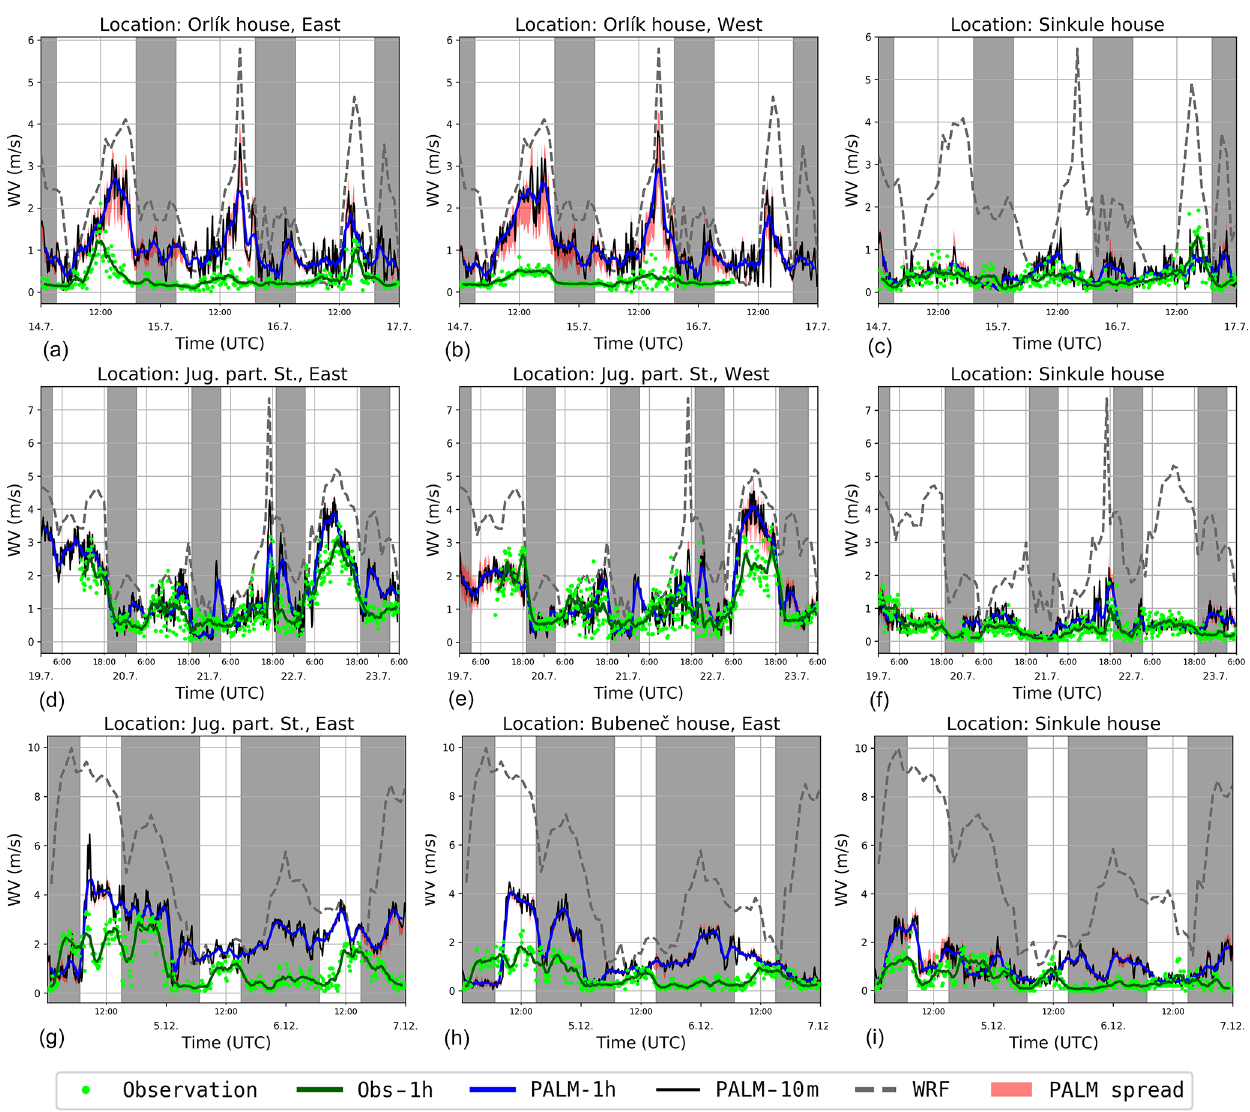
Figure 27. Street canyon wind speed at 10m (Sinkule house) and 6.8m (other) for the summer e1 (a, b, c) , summer e2 (d, e, f) , and winter e3 (g, h, i) episodes. Observations are shown as 10min averages (green dots) and moving 1h averages (green line). PALM simulations are shown as moving 1h averages (blue line), 10min averages (solid black line), and the interval between the smallest and the largest 10min average among neighbouring grid points (red band). The grey dashed line denotes 1h averages at 10m at the closest WRF grid point. The grey shaded areas indicate